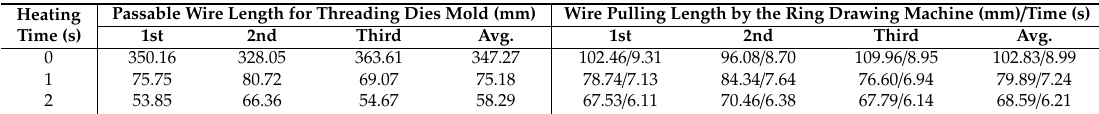
Table 6. Results based on wire pulling speed: k6(11.04 mm / s).